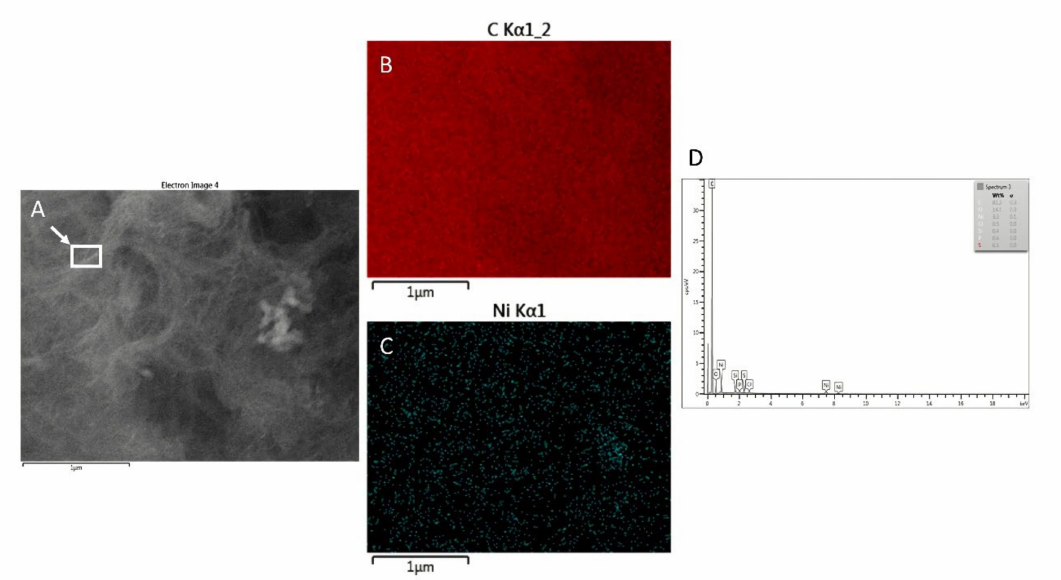
Figure 4. EDX analysis of SPCE/MWCNT/NiO1.5: SEM image used for the EDX analysis ( A ), distribution of carbon ( B ) and nickel ( C ) on the electrode surface, elements on the electrode surface in wt% ( D ) obtained from the marked place.